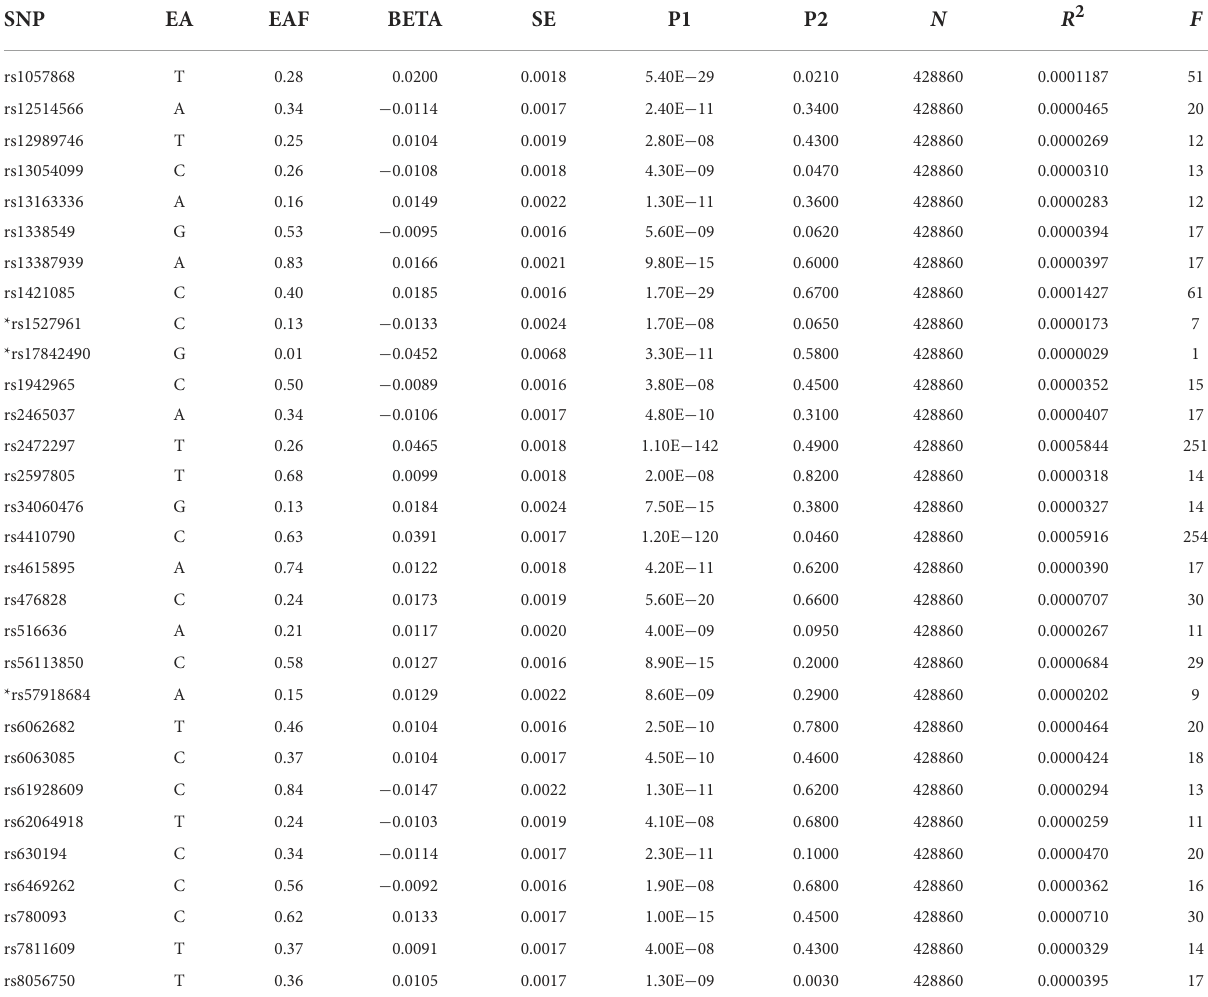
TABLE 3 Characteristics of SNPs associated with coffee